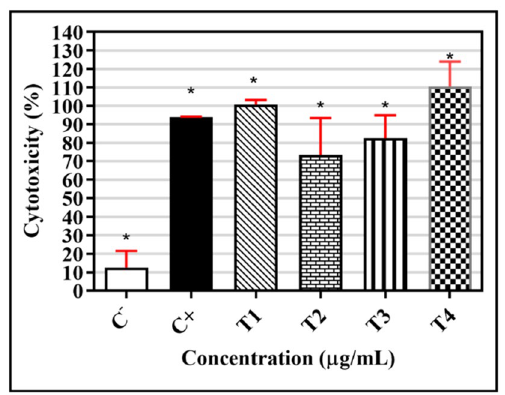
Figure 7. T1 , T2 , T3 , and T4 toxicity in human macrophages Cells (1.0 × 10 6 /mL) were treated with 47 µg/ mL of T1 , 530 µg/mL of T2 , 9 µg/mL of T3, and 121 µg/mL of T4 for 24 h at 37 °C and 5% CO 2 oven. The cytotoxicity was evaluated via incubation with MTT (5 mg/mL) for 3 h at 37 °C, followed by colorimetric stabilization with SDS (10%) overnight, and subsequent absorbance reading at 540 nm. The data are expressed as mean ± standard deviation of the percentage cytotoxicity of four individual triplicates; *p < 0.05, for Mann– Whitney test, compared to the negative